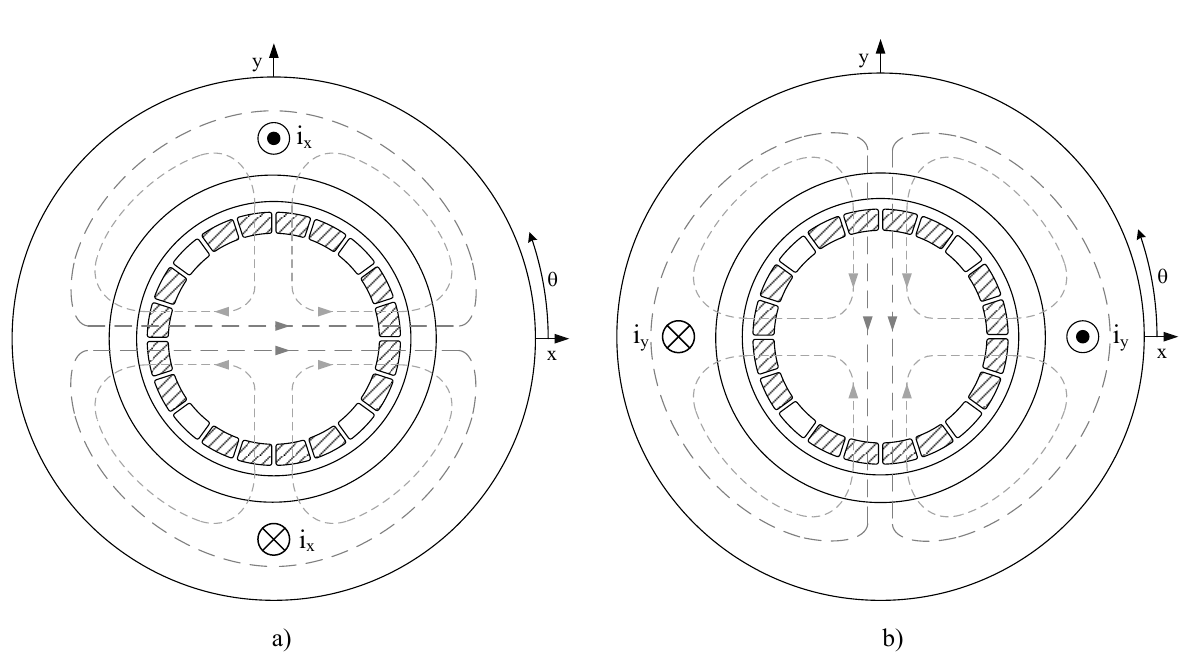
Figure 6: Description of radial force generation in a permanent magnet bearingless motor. The three-phase windings are transformed into a two-phase presentation in the xy plane. The currents of the two-phase windings are denoted by i x and i y . The principle of producing radial force in the x -axis is shown in a). By applying current to the x phase windings, the flux is increased and decreased opposite to the air gap in x -axis. This flux unbalance produces the radial force. By applying negative current, the force direction can be reversed. In a similar fashion, the radial force in the y -axis can be produced by applying current in the y -phase winding.